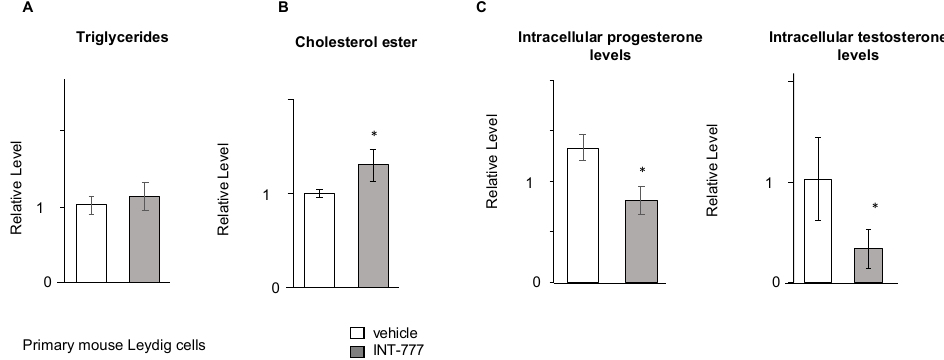
Figure 8. TGR5 signaling was effective in mouse primary Leydig cells. ( A ) Relative intracellular levels of triglycerides in mouse primary Leydig cells normalized to protein concentration 3 h after treatment with vehicle or INT-777. ( B ) Relative intracellular levels of cholesterol esters in mouse primary Leydig cells normalized to protein concentration 3 h after treatment with vehicle or INT-777. ( C ) Relative intracellular levels of progesterone and testosterone in mouse primary Leydig cells normalized to protein concentration 3 h after treatment with vehicle or INT-777. In all panels, n = 3 to 6. Data are expressed as the means ± SEM. Statistical analysis: * p <